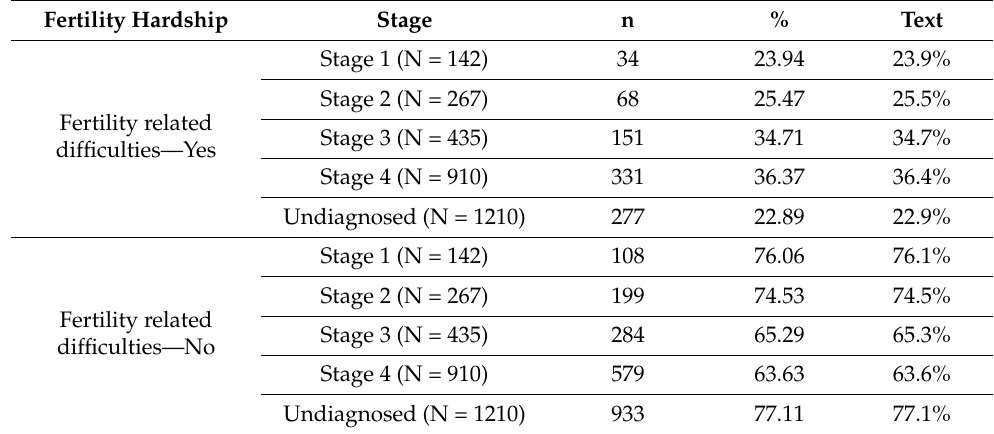
Table 6 and Figure 5 show the comparison between the observed distribution of pain minus the expected distribution of pain to the particular stage of endometriosis. Positive or negative results demonstrate a category of pain that is overrepresented or underrepresented within that stage,